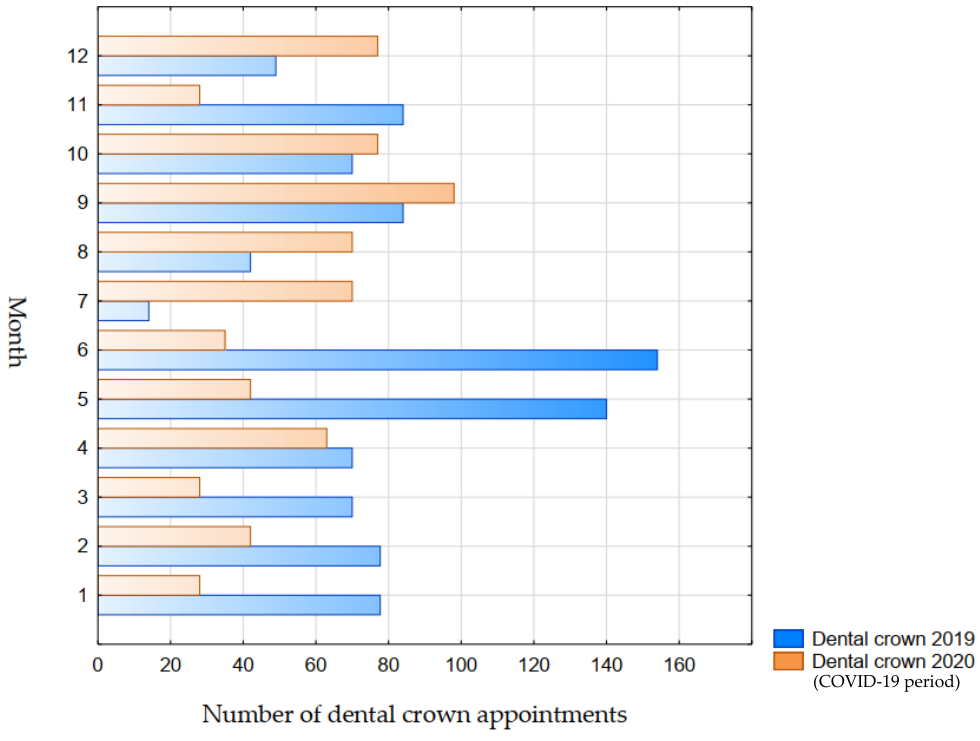
Figure 6. Change in the number of dental crown appointments during the pandemic period from the prepandemic period.